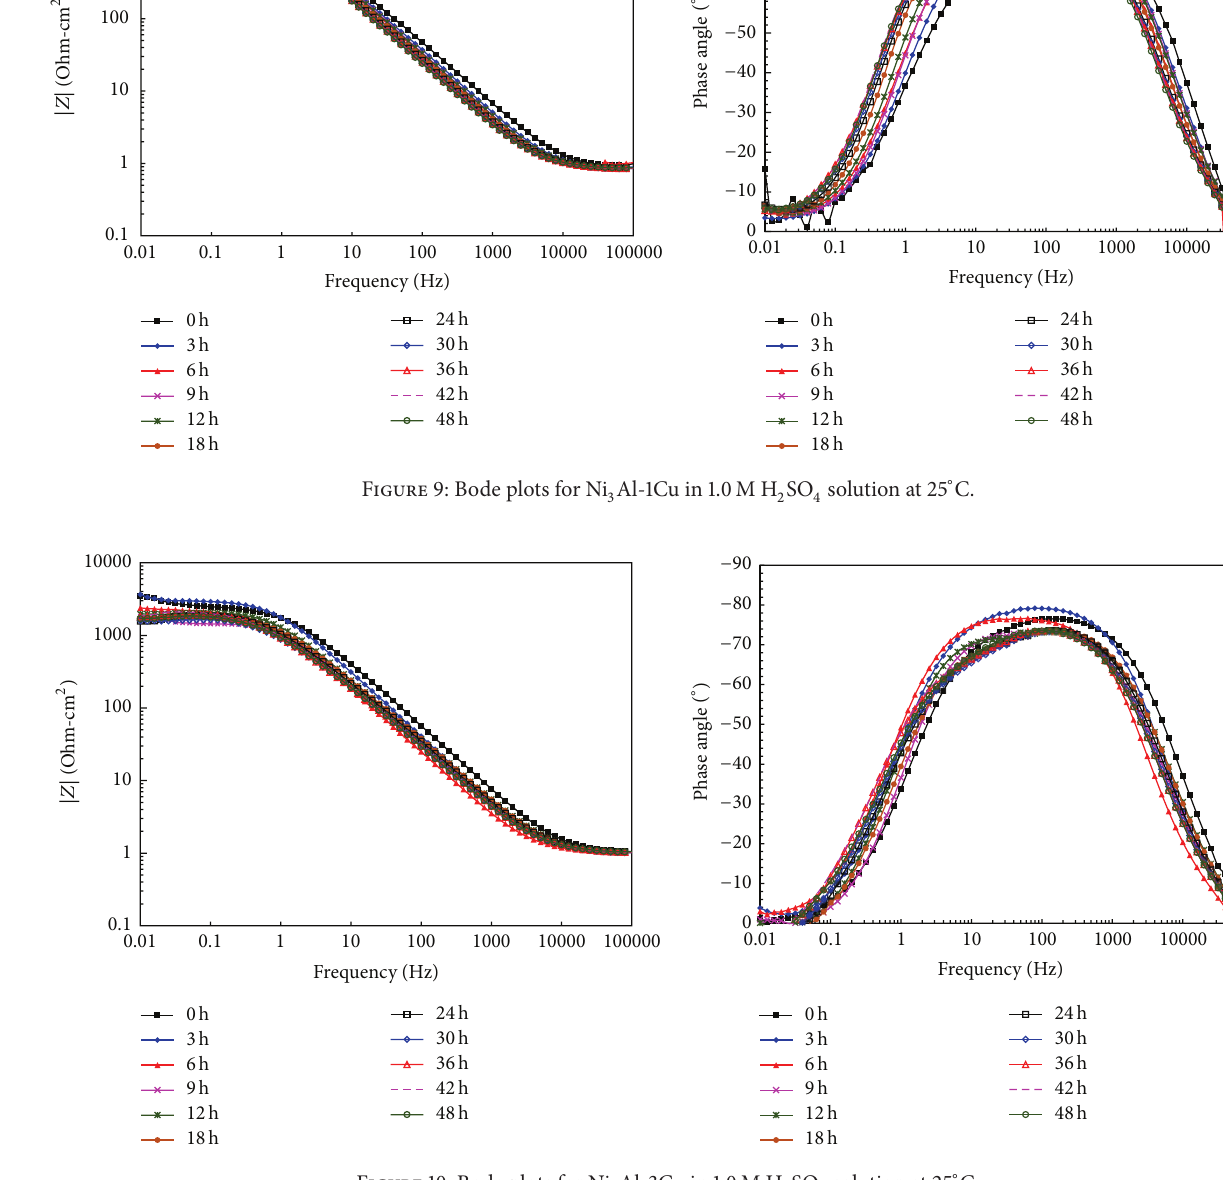
Figure 10: Bode plots for Ni 3 Al-3Cu in 1.0 M H 2 SO 4 solution at 25 ∘